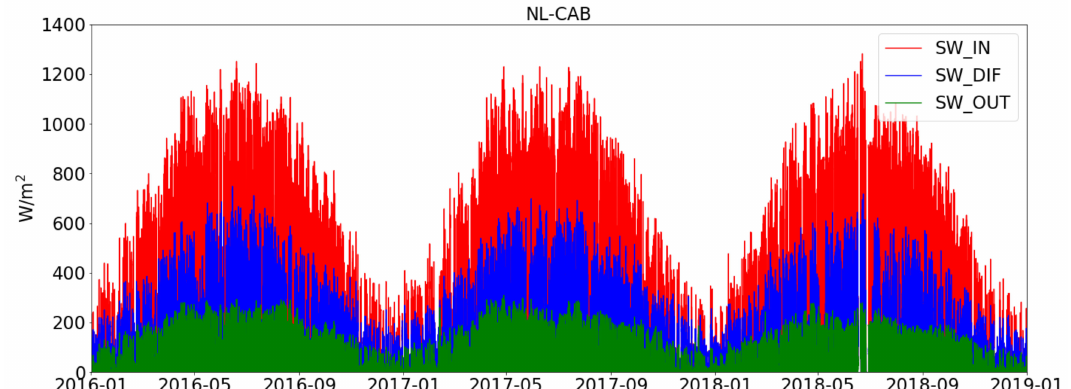
Figure 4. Time series of raw measurements at the NL-CAB tower site between 1 January, 2016 and 31 December, 2018. Incoming shortwave (SW_IN), outgoing shortwave (SW_OUT) and incoming di ff use shortwave radiation (SW_DIF) are represented by red, green and blue lines,